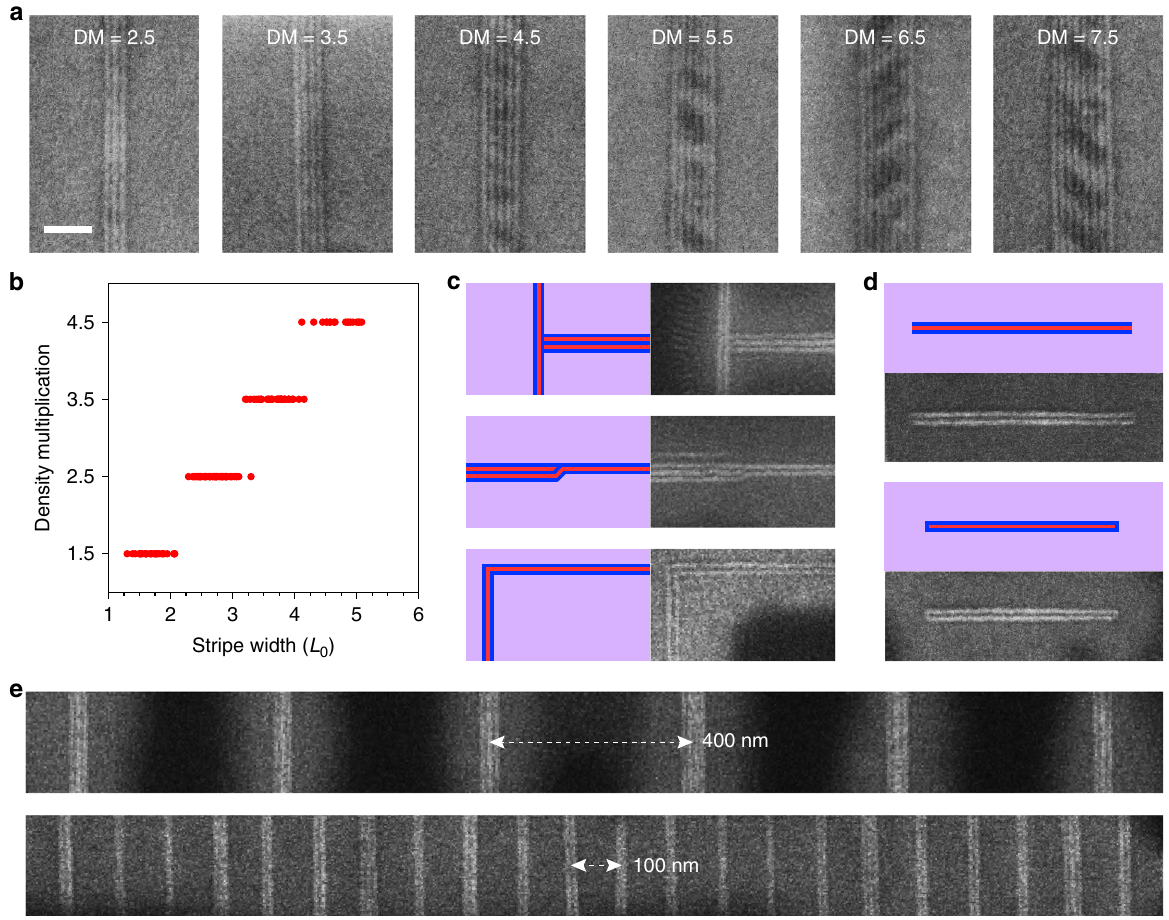
Fig. 2 Density multiplication and pattern formation. a SEM images of PPC-b-PS ( L 0 of 16.8 nm) after assembly on stripes with widths of ~2.5, 3.5, 4.5, 5.5, 6.5, and 7.5 L 0 (left to right). b Plot of density multiplication factor (DM) versus stripe width for PPC-b-PS-b-PPC ( L 0 of 12.8). c PPC-b-PS-b-PPC ( L 0 of 12.8 nm) assembled into various patterns, including T-junctions (top), jogs (middle row), and 90° bends (bottom). d PPC-b-PS-b-PPC ( L 0 of 12.8 nm) assembled to form isolated arrays of three lines. On some stripes, vertical PS lamellae directly border both the long and short stripe edges (bottom), whereas on other stripes (most often, when width is ~1.5 L 0 ), vertical PS lamellae only directly border the long stripe edges (top). Vertical PS and PPC lamellae are blue and red, respectively, and horizontal lamellae are purple. Scale bar for a , c , d (shown in a ) is 100 nm. e SEM images of PPC-b-PS-b-PPC ( L 0 of 12.8 nm) assembled on seeded stripe arrays with superstructure pitch of 400 (top) and 100 nm